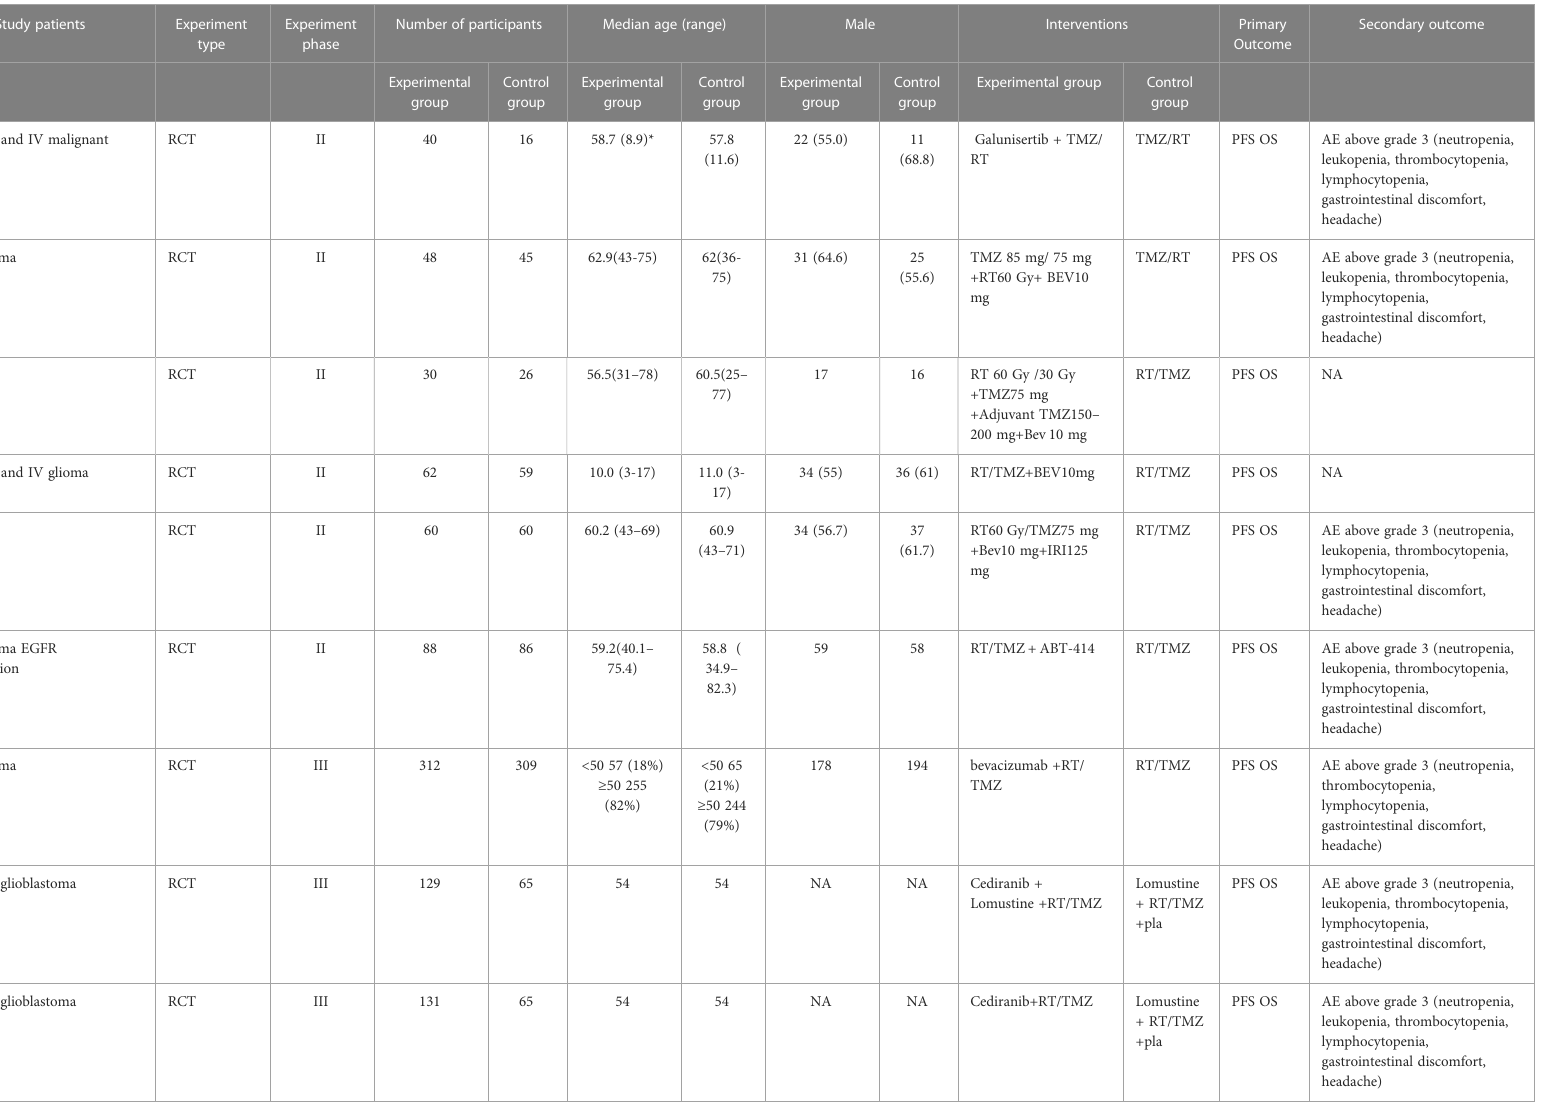
TABLE 1 Basic characteristics of the studies included in this